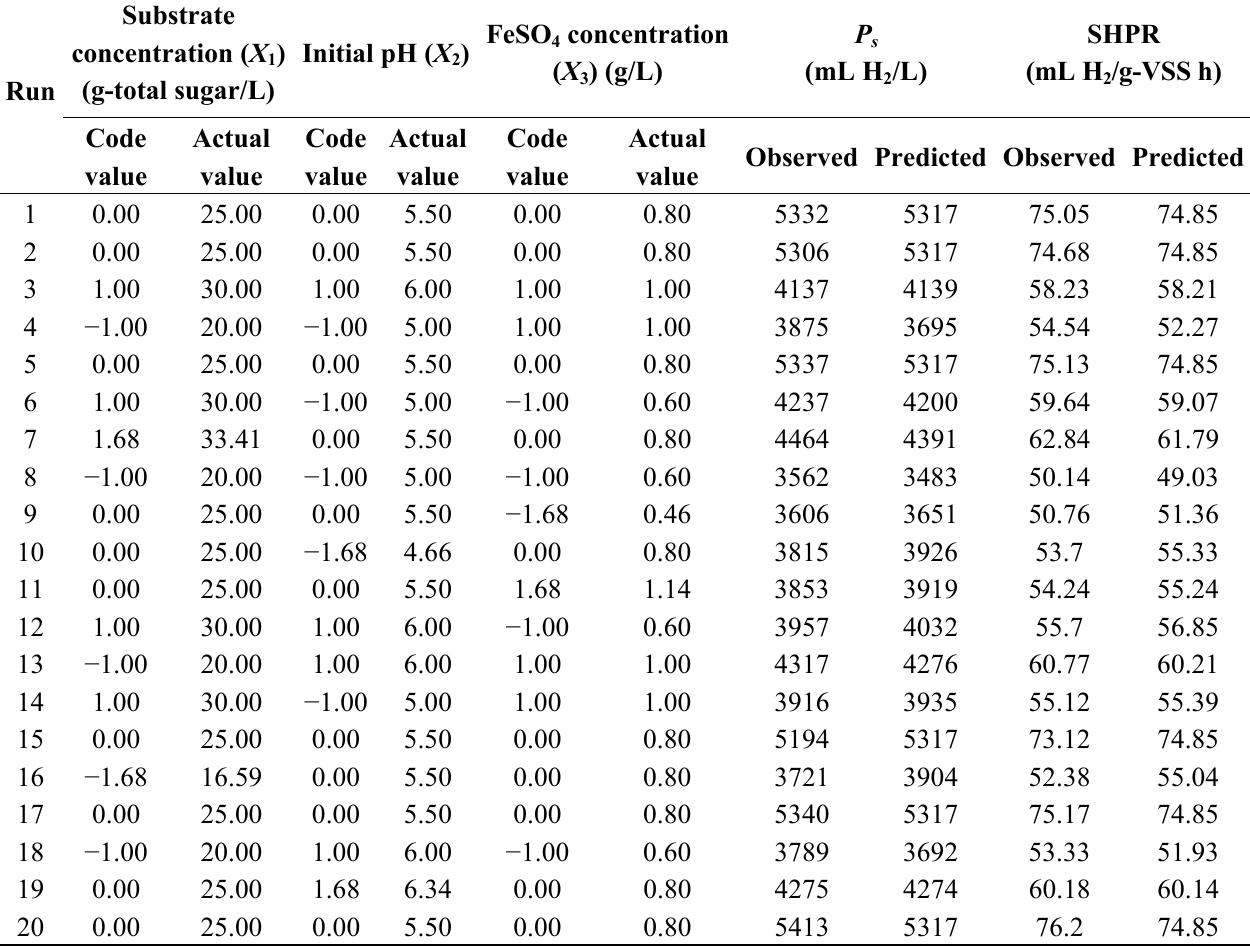
Table 3. Central composite experimental design matrix defining pH, substrate concentration and FeSO concentration for optimizing the fermentative hydrogen production process and 4 the corresponding experimental results.